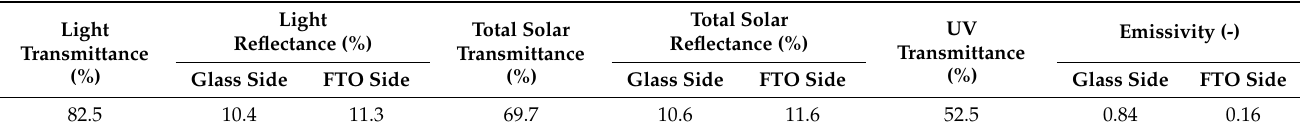
Figure 1. Transmittance and reflectance of heated glass at various wavelengths. Table 1. Optical properties of heated glass.